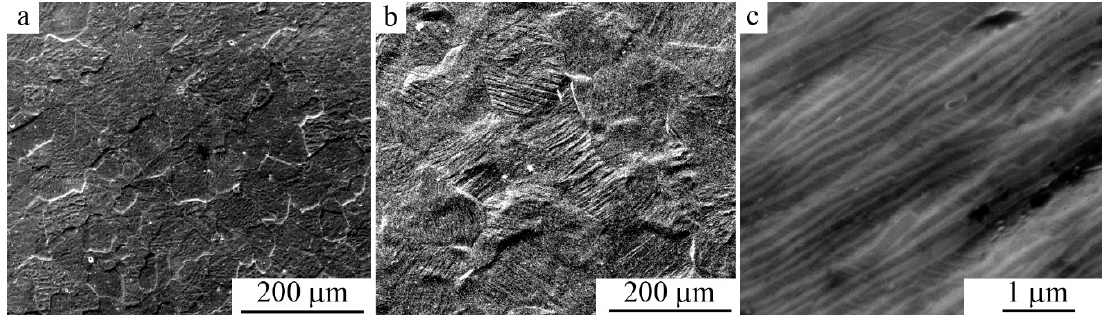
Figure 6. SEM images of the microstructure of Ti 49.4 Ni 50.6 alloy: ( a ) In the austenitic state and ( b , c ) in the single-packet martensite state after treatment with a pressure of 6 GPa. (cid:48) The flat coherent boundaries of crystals of B19 martensite of di ff erent orientations within the packages occur, as a rule, along the planes (011), as well as (111) and (113) B19 (cid:48) [40,41,49–54]. The packet